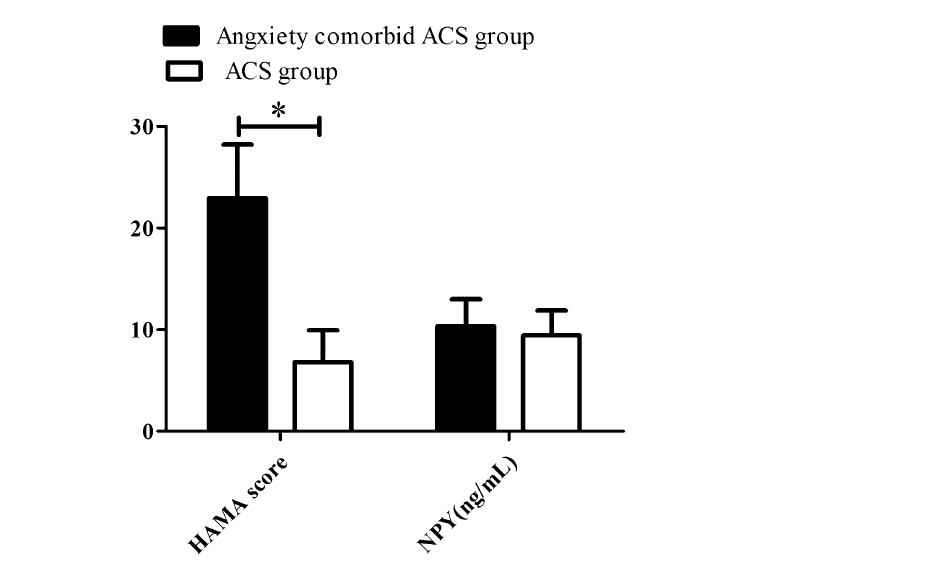
Figure 2. Effect of anxiety on HAMA score and NPY in ACS patients. Data are presented as mean ± SD (* p < 0.05).